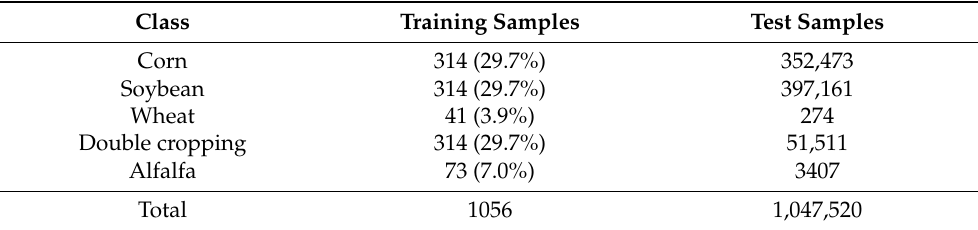
Table 5. Numbers of training and test samples for five crop types. The percentage value in parentheses of the training samples indicates the relative proportion for each class.